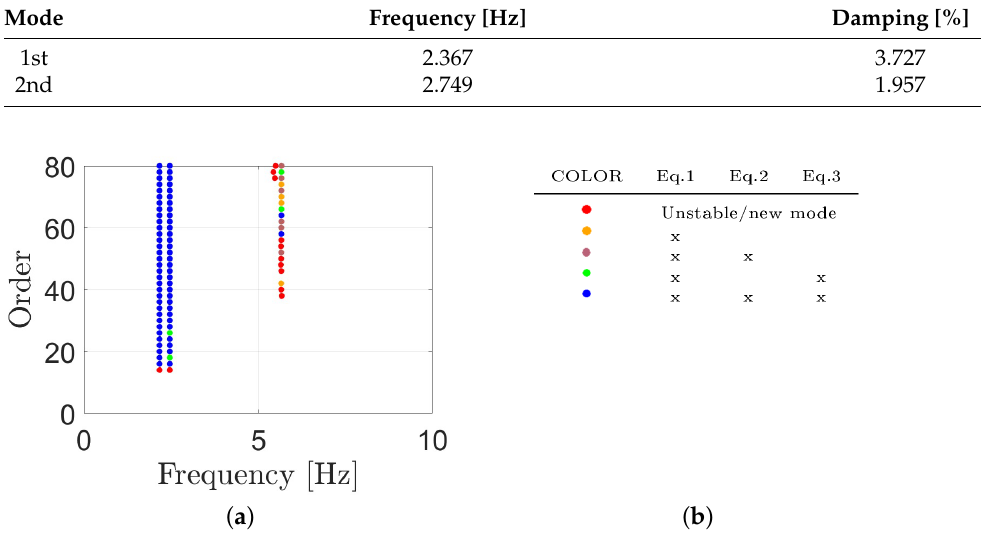
Table 2. Results of Operational Modal Analysis (OMA).